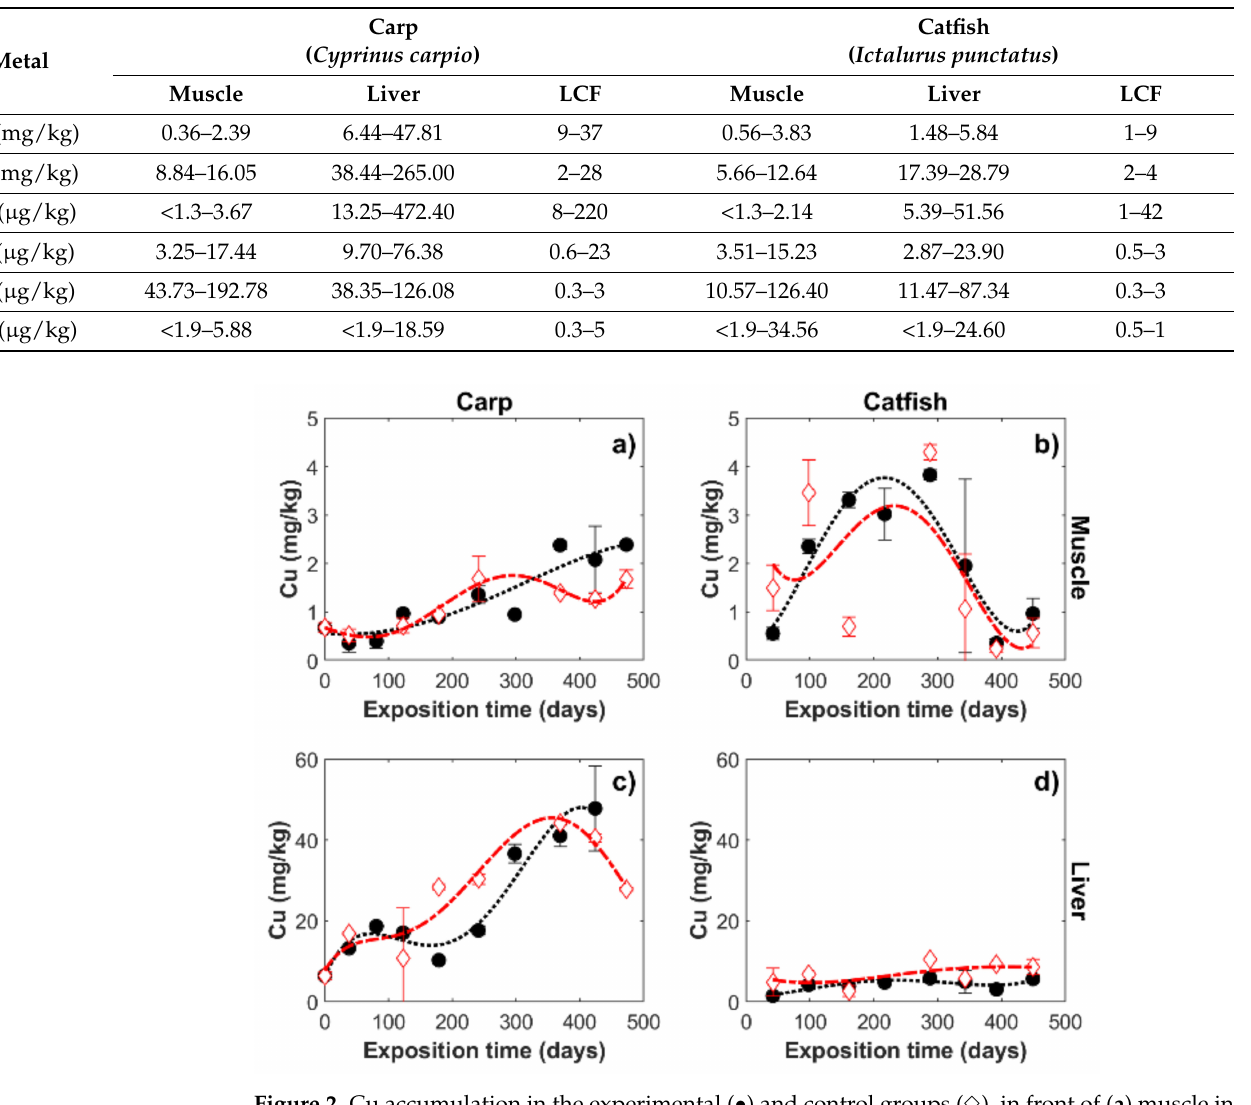
), in front of ( a ) muscle in (cid:51)